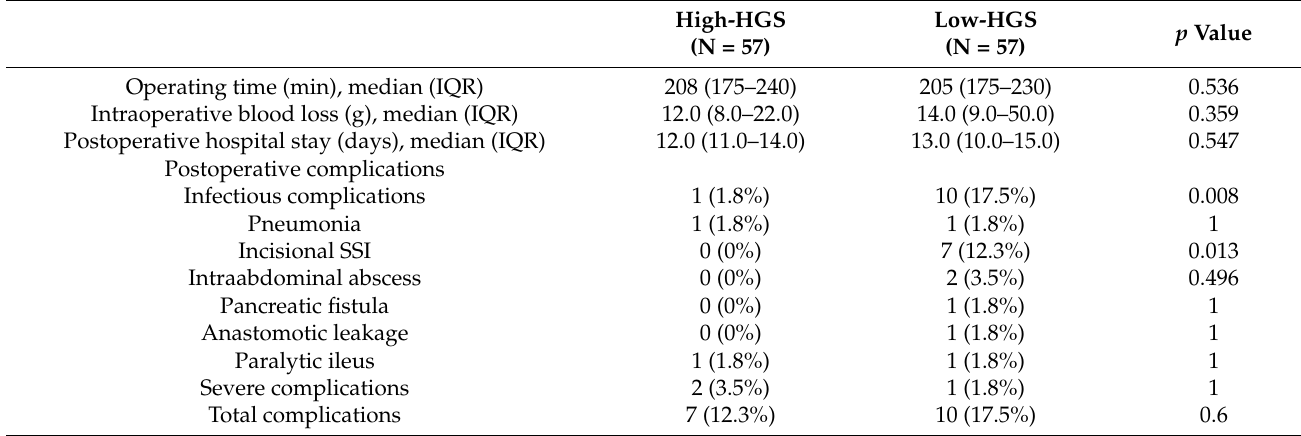
Table 3. Comparison of postoperative outcomes after matching.